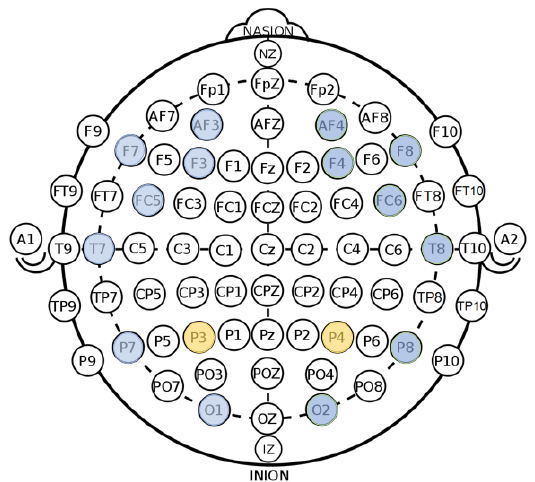
Figure 2. Sensor location. The electrodes’ positions employed in this study are